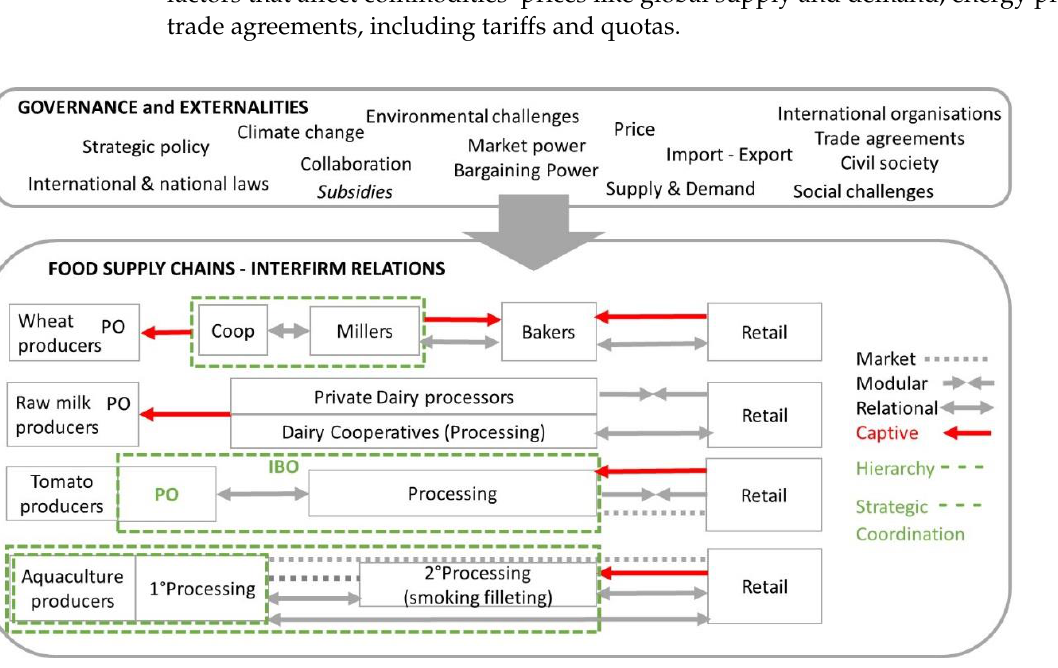
Figure 3. Governance and externalities influencing the functioning of the food system and the type of interfirm relations between key actors in the FVC case studies (authors ’ interpretation based on of interfirm relations between key actors in the FVC case studies (authors’ interpretation based on [8]. [8]. Note: PO: Producer Organisation, IBO Interbranch Organisation, Coop: Cooperative. Note: PO: Producer Organisation, IBO Interbranch Organisation, Coop: